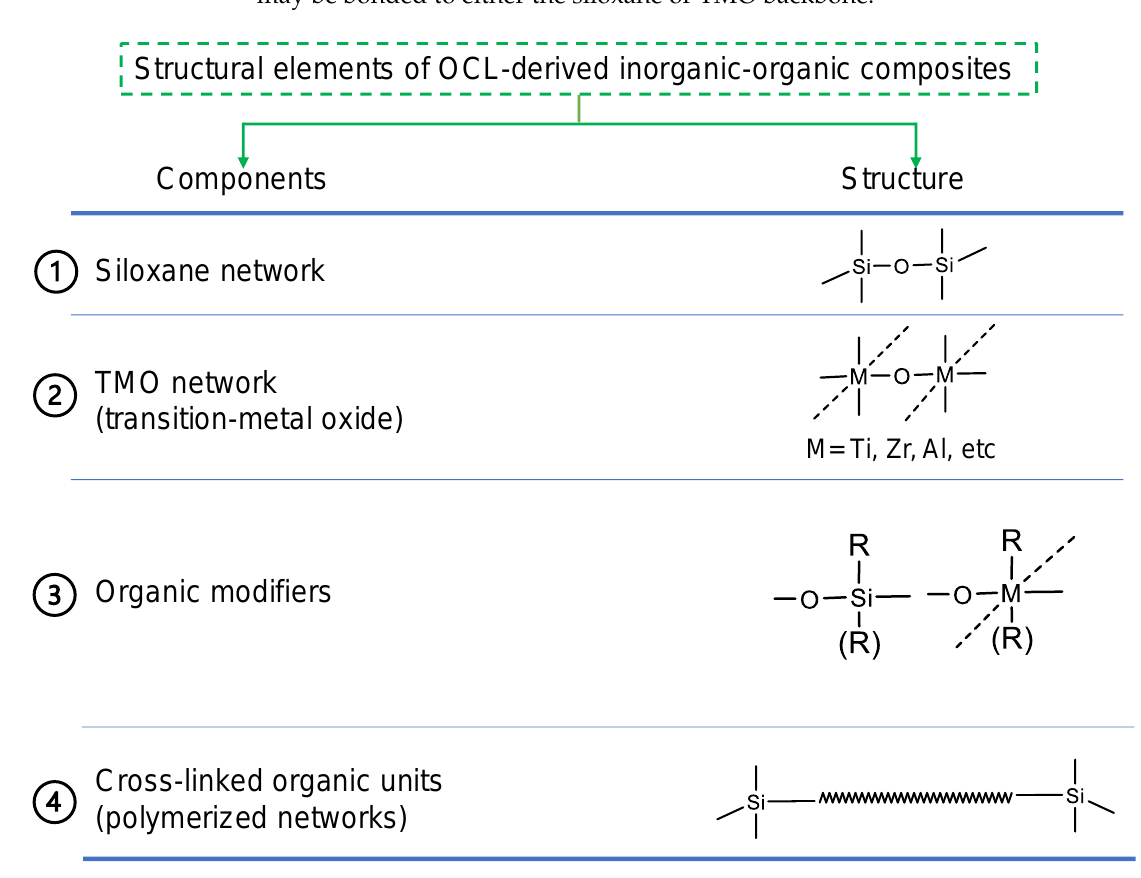
Figure 9. Structural elements in the formation of organic chelating ligand-derived inorganic–organic composites. Adapted from [80].